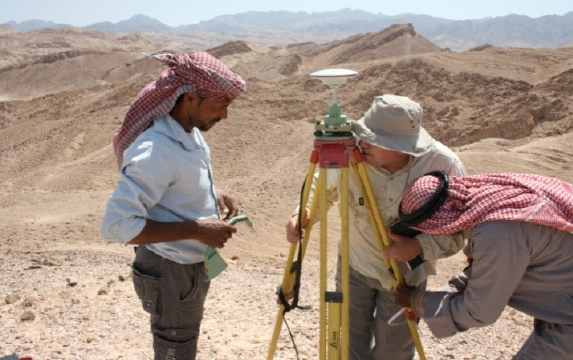
Figure 2: mapping the boundaries using a base station to enhance